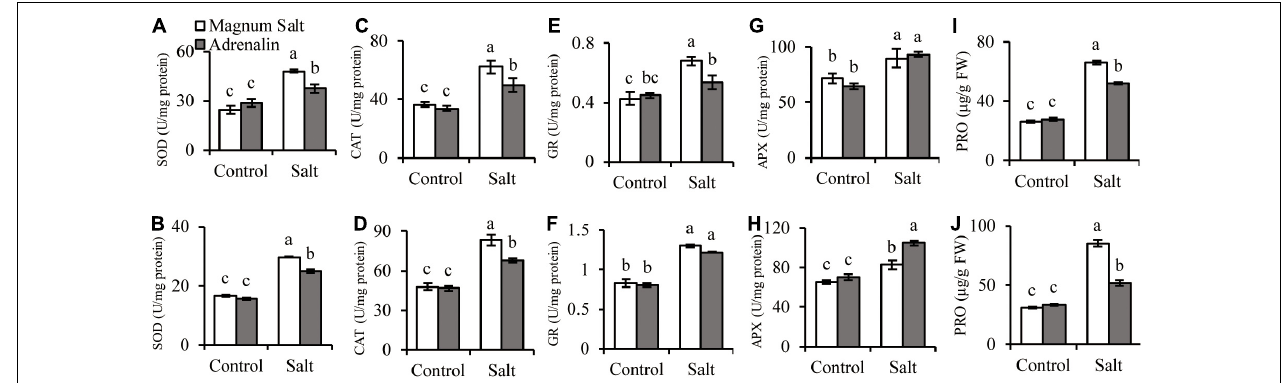
FIGURE 4 | Effect of salt treatment on the antioxidant enzyme activities and proline content in Magnum Salt and Adrenalin. Four-week old seedlings grown in soil with a mixture of pearlite, vermiculite and perlite (1:1:2) were treated with 0 or 500 mM NaCl for 6 days. SOD, CAT, GR, and APX activities and proline contents were analyzed in both root (A,C,E,G,I) and shoot (B,D,F,H,J) . Values are mean ± SE ( n = 3 replicates). Different letters indicate the significant differences ( P < 0.05, LSD) between two cultivars or treatments.